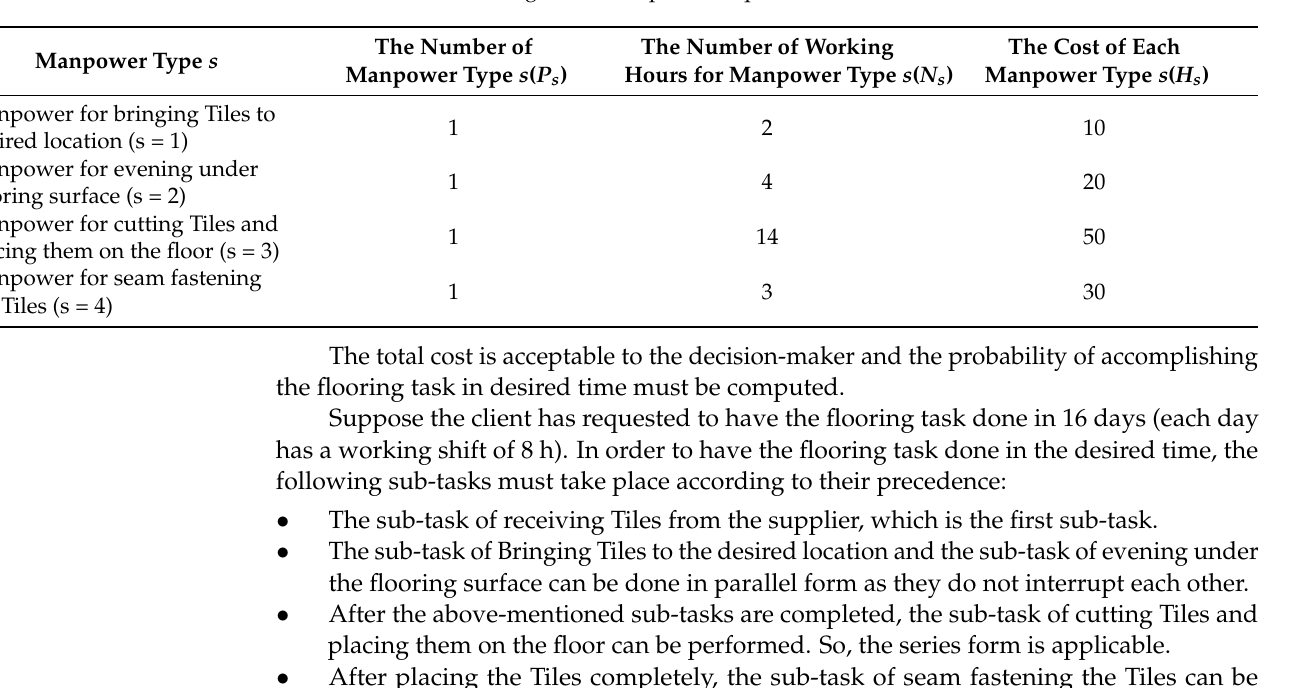
Table 12. Data for flooring task’s manpower